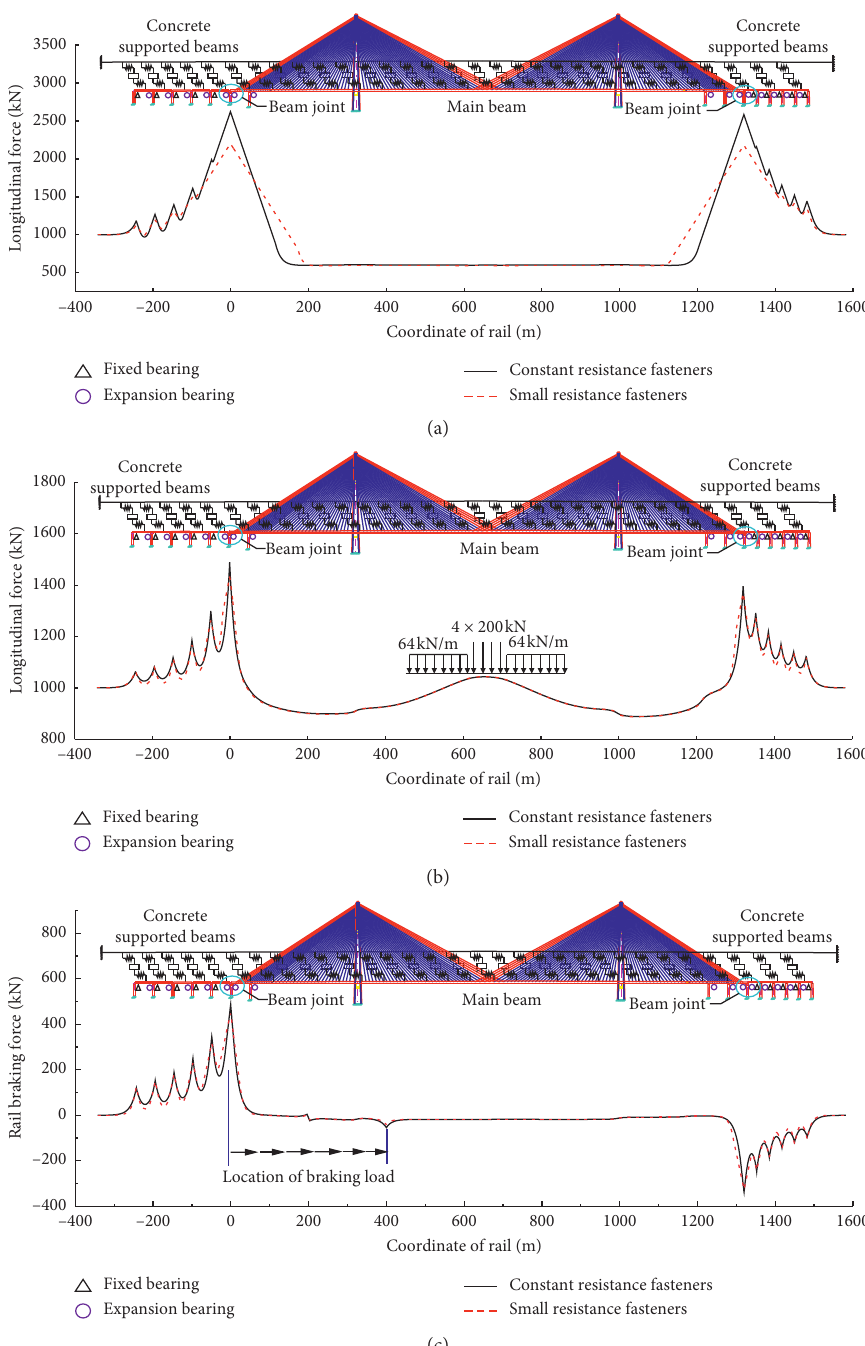
Figure 5: Rail longitudinal force. (a) Longitudinal force under temperature drop condition. (b) Longitudinal force under bending condition. (c) Longitudinal force under braking